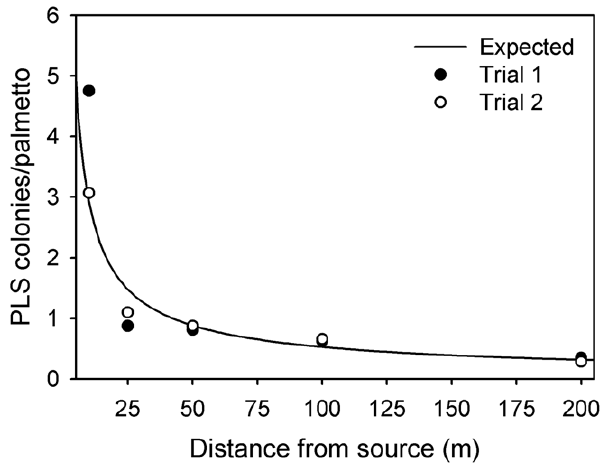
Figure 5. The relationship between distance from the source of PLS and the number of newly formed PLS colonies on potted palmettos. Data are reported for two trials and the curve is the expected number of colonies based on the inverse power function ( ln colony number= 2 0.75*[ ln distance] + 2.79; R 2 =0.90, P , 0.001).